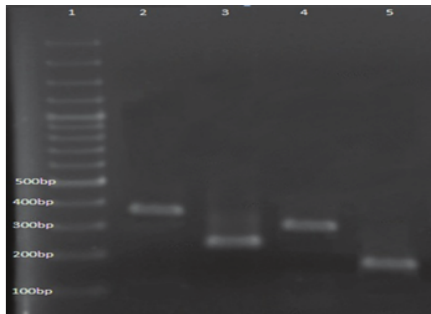
Figure 1: PCR products amplified with different primers and separated on agarose gel electrophoresis. Lane 1, molecular weight ladder; Lane 2, E. faecalis ; Lane 3, E. faecium ; Lane 4, E. casseliflavus ; Lane 5, E. gallinarum